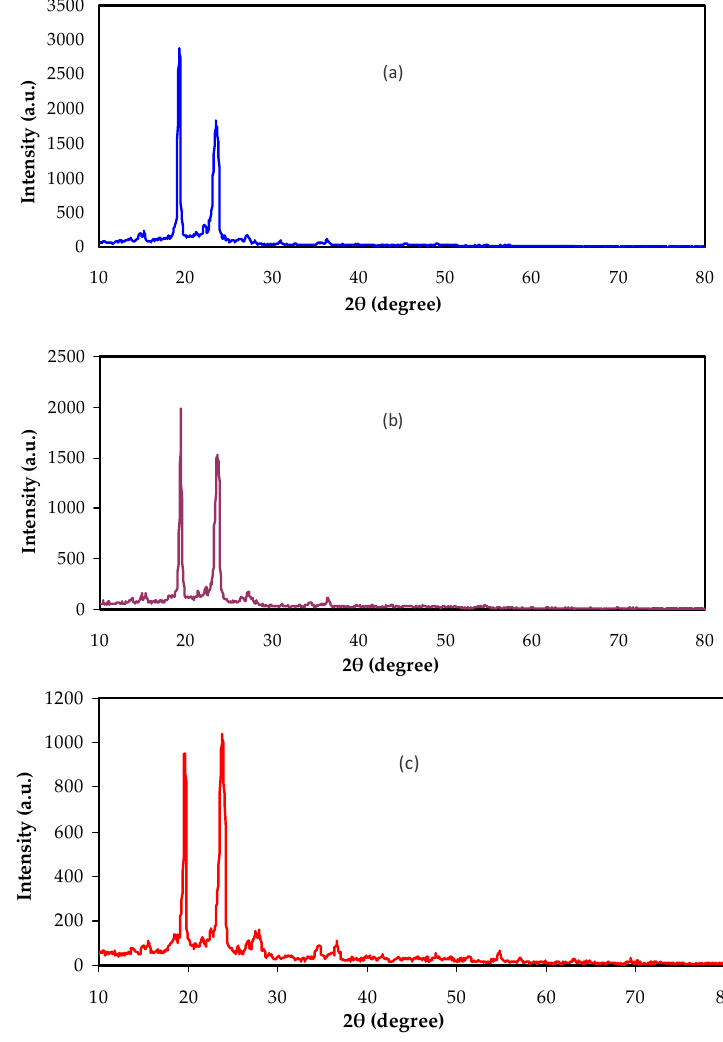
Figure 2. XRD spectra for ( a ) Pure PEO, ( b ) NCP-1, and ( c ) NCP-2.